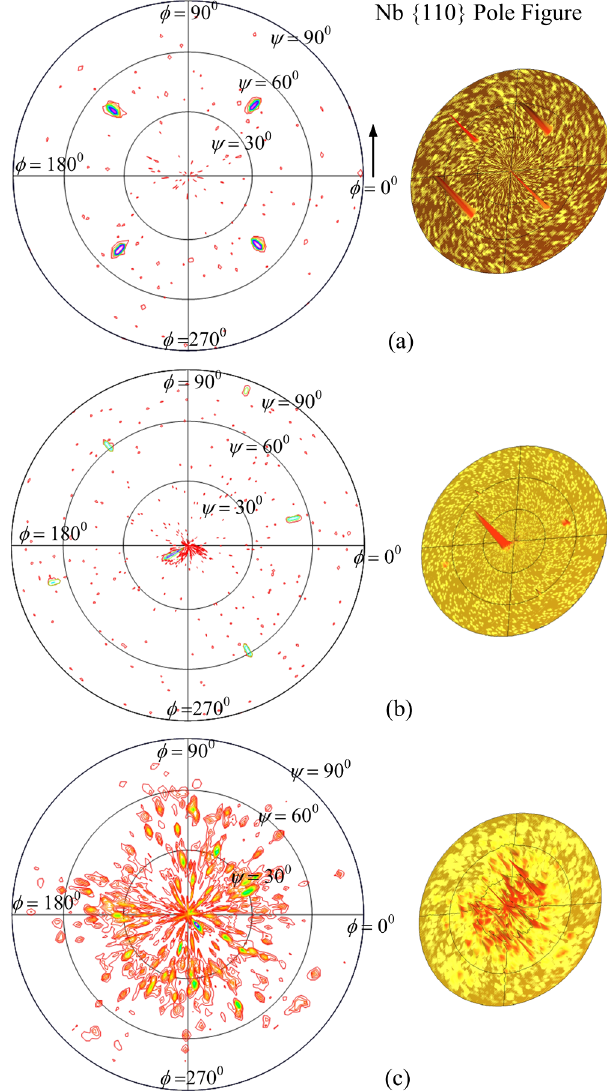
FIG. 2 (color online). Experimental Nb f 110 g pole figures. (a) Sample CED-034: a Nb(100) film on Mgo (100) substrate. (b) Sample Nb-SC-01: a single crystal bulk Nb (110) coupon. (c) Sample Nb-PC-01: a polycrystalline bulk Nb coupon. The right column shows a 3D view of the pole